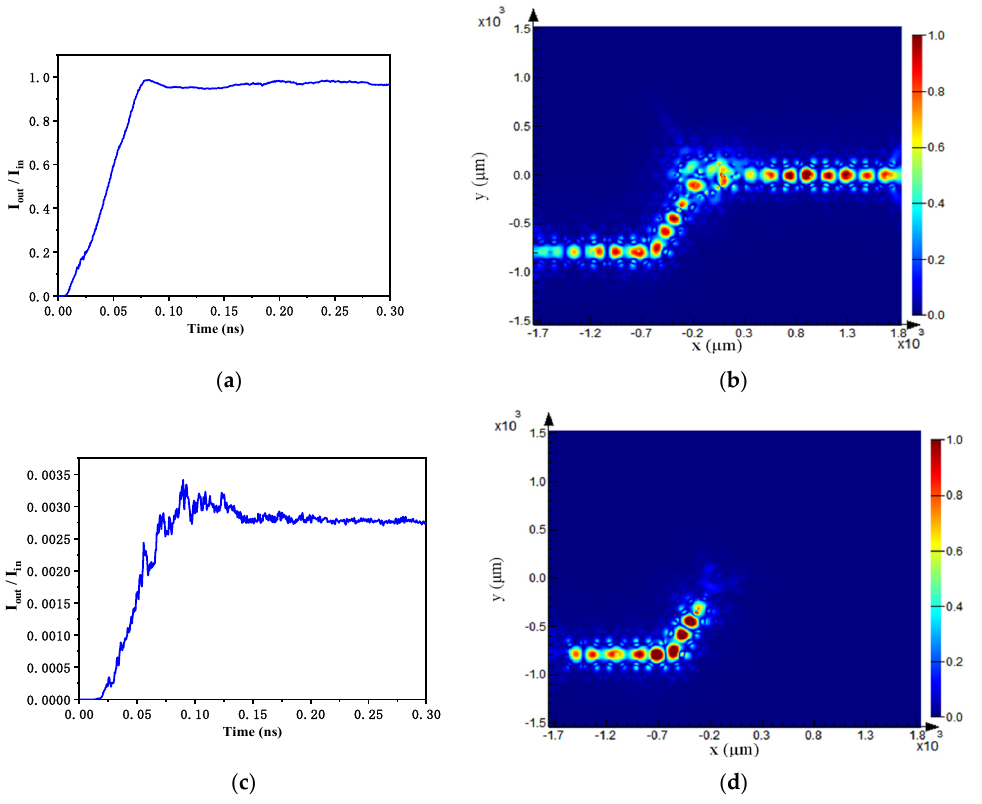
Figure 6. Port B as the input port. The time domain steady-state response ( a ) and steady-state field distribution ( b ) without pump excitation, and the time domain steady-state response ( c ) and steady-state field distribution ( d ) with pump